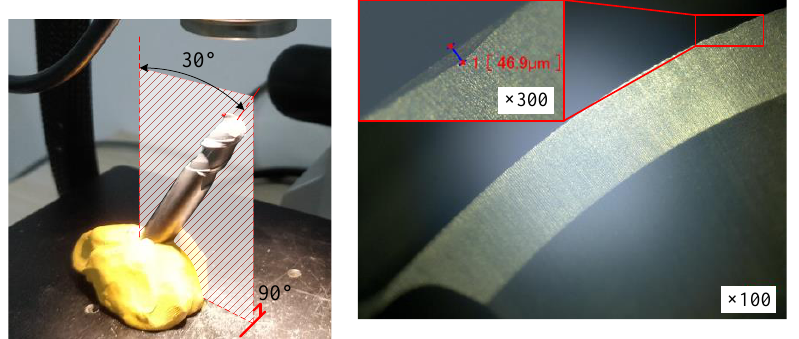
Figure 11. Wear measurement method and result.